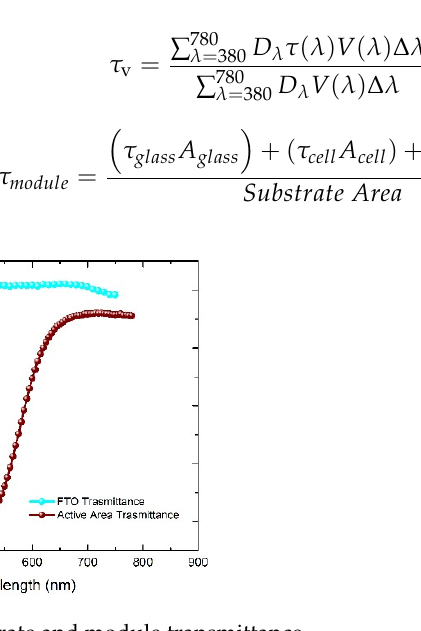
Figure 10. Glass substrate and module transmittance. Table 2. Transmittance values of the various components of the module and relative area in cm 2 .